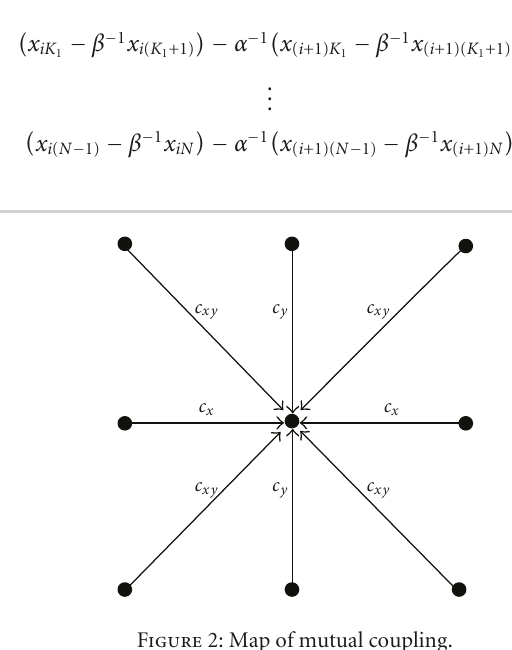
Figure 2: Map of mutual